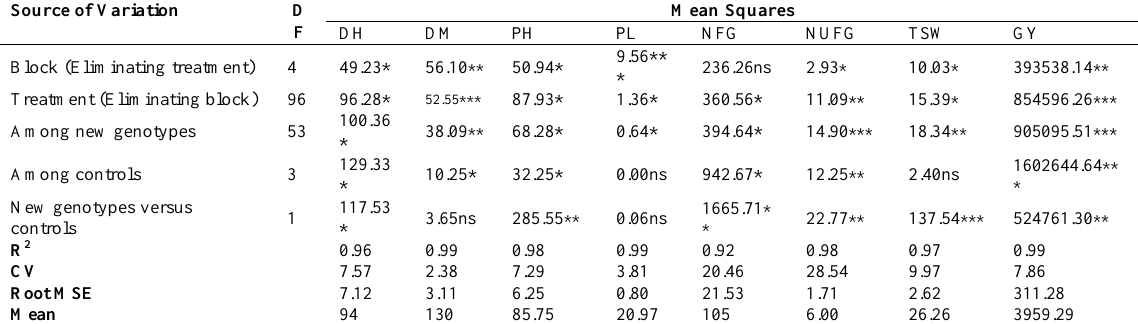
Table 2. Analysis of variance and performance mean value for eight quantitative traits of the tested 97 upland rice genotypes.